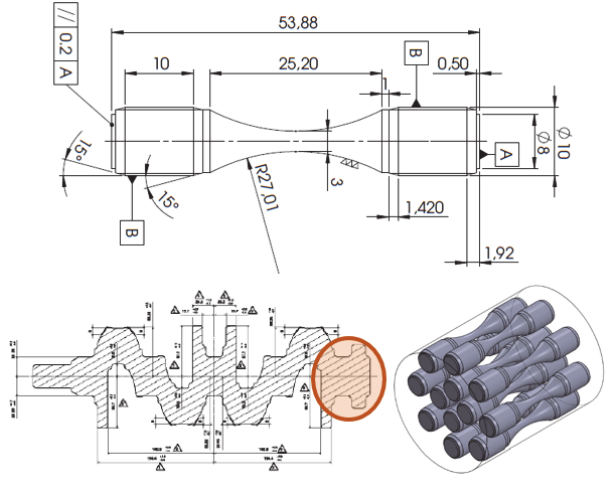
Figure 1: Specimen extraction and fatigue specimen geometry for resonance